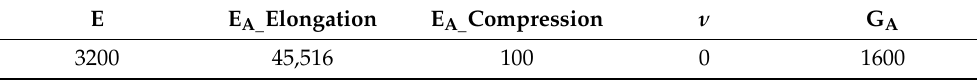
Table A2. Material parameters identified in the mesoscopic simulations (in